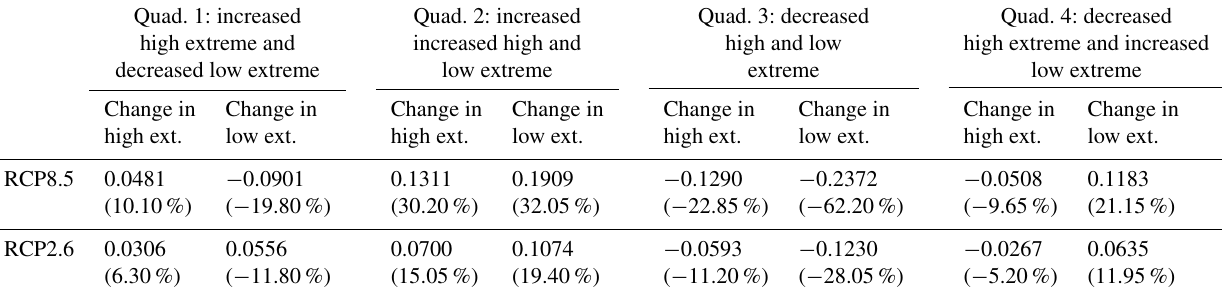
Table 3. Multi-model average change in high and low streamflow extremes, averaged for each quadrant, for the RCP2.6 and RCP8.5 scenar- ios. The numbers show the normalized change and the numbers in parenthesis show the changes reverted to the relative percentages. Quad. 1: increased Quad. 2: